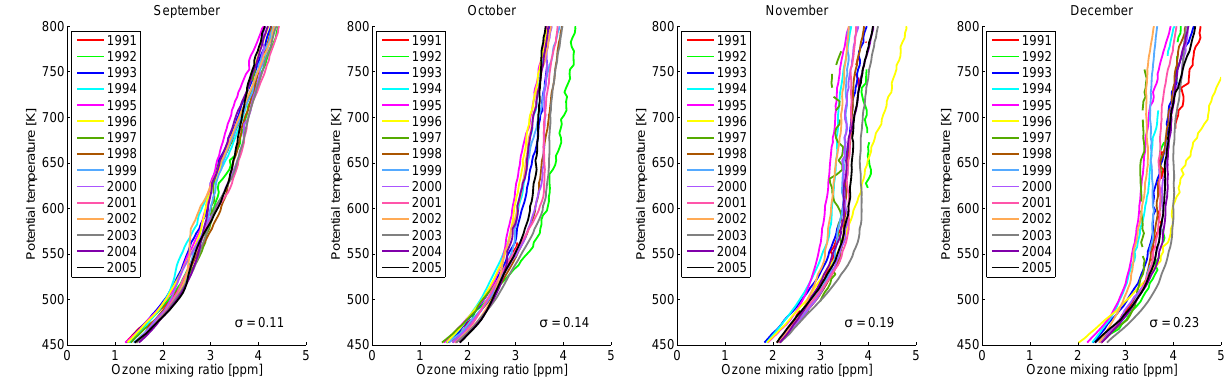
Fig. 1. Monthly mean profiles of ozone mixing ratios in the polar vortex for the months from September to December and the years 1991– 2005. The vortex is defined as the area north of 65 ◦ N equivalent latitude. Measurements are from satellites and ozone sondes (see text for details). The standard deviation of the monthly mean ozone mixing ratios in the vortex between 500–700K is shown for every month in the lower right